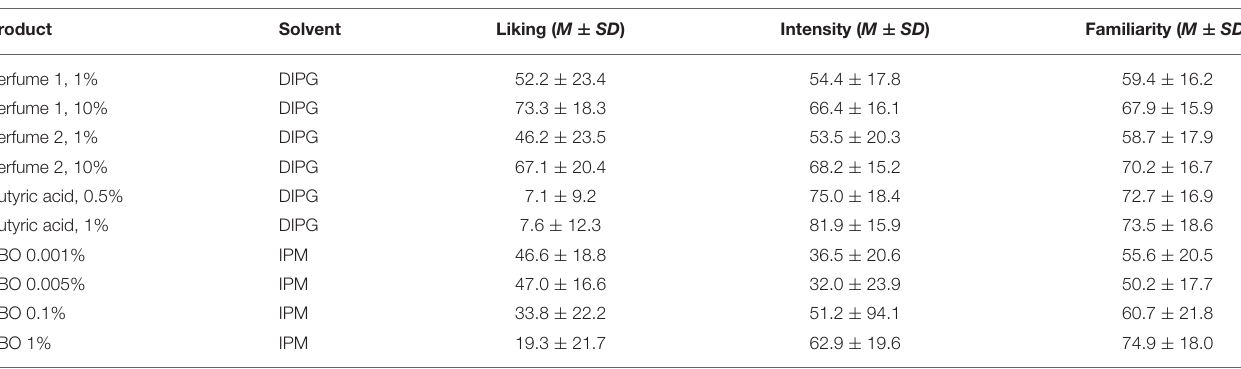
TABLE 2 | Pretested set of